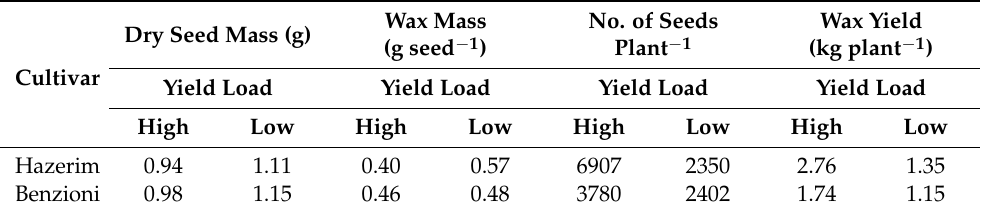
Table 2. Effect of yield on dry seed mass, wax mass, number of seeds per plant, and wax yield per plant in Hazerim and Benzioni. Seed and wax mass values are the means of 12 seeds per cultivar. We calculated the number of seeds per plant by dividing the total yield by the seed mass, and then dividing by the number of female plants per hectare (Equation (1)). Wax yield per plant was calculated by multiplying wax mass by the number of